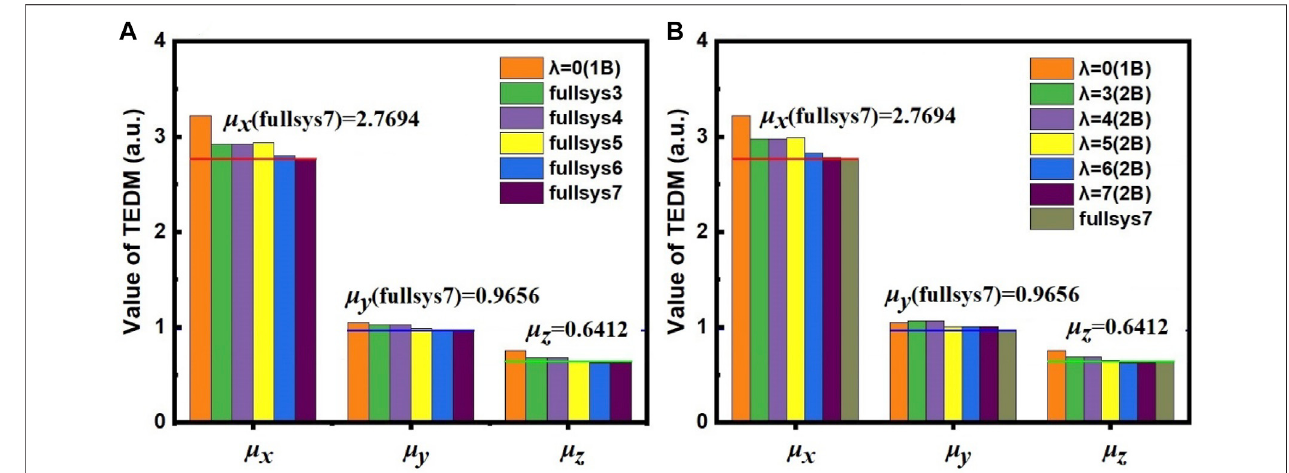
FIGURE 4 | The calculated μ x , μ y , and μ z of TEDM with (A) full-system calculations and (B) the EE-MFCC method for different model systems constructed using various λ FS at the TD-HF/6-31G* level. The red ( μ x ), blue ( μ y ), and green ( μ z ) lines denote the corresponding values calculated on the truncated full system of fullsys (7).